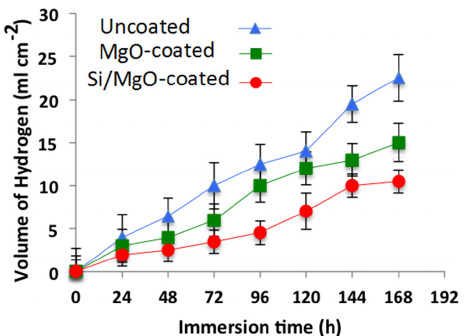
Figure 9. Hydrogen evolution during immersion of uncoated, MgO ‐ coated and Si/MgO ‐ coated in SBF solution for duration of 168 h.